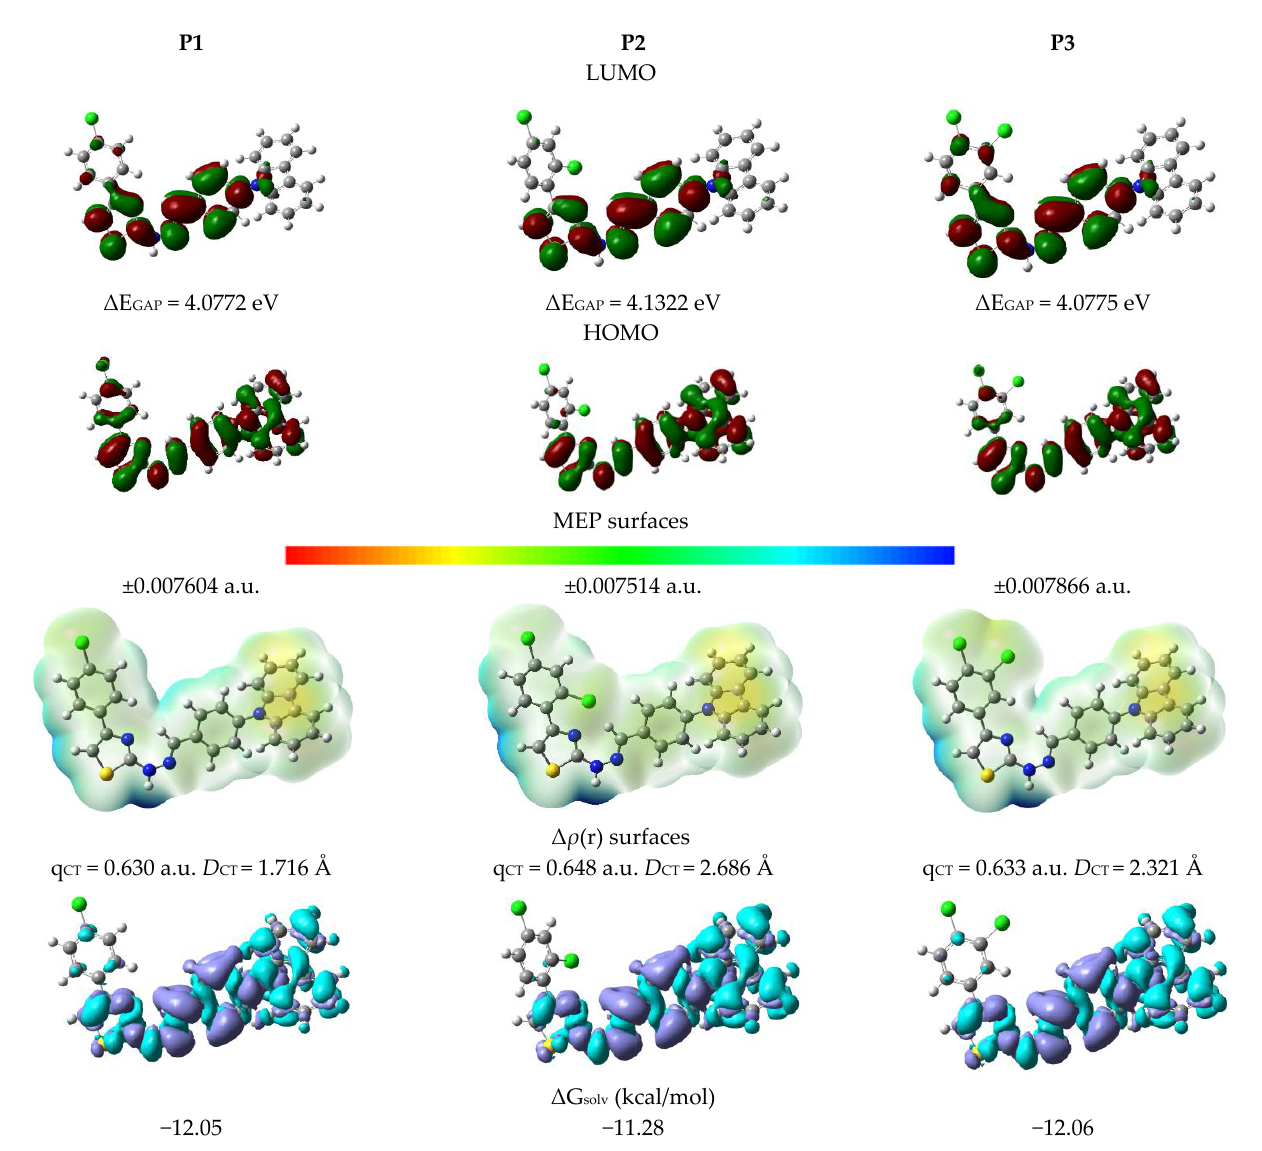
Figure 4. Physicochemical properties in water.